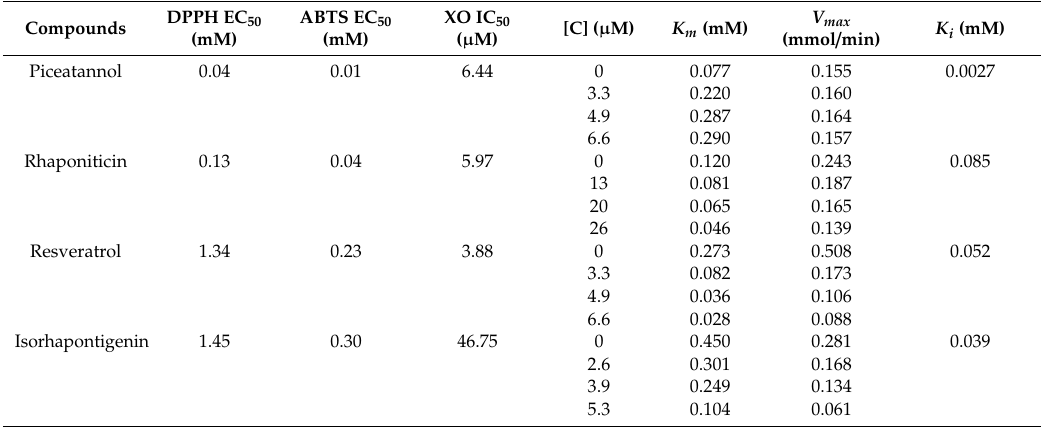
V max K i (mM) (mmol / min)